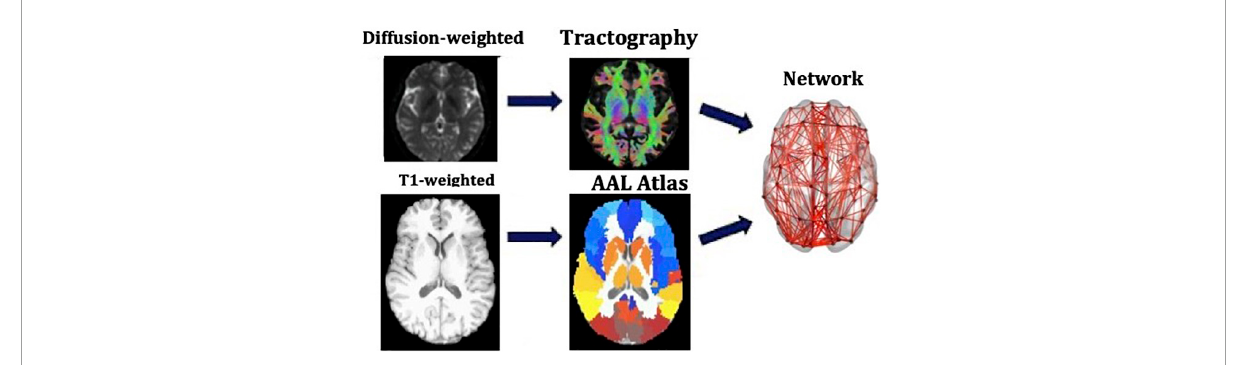
FIGURE1 Analysis that leads from the MR images to the structural brain networks. This analysis is repeated for each participant individually.